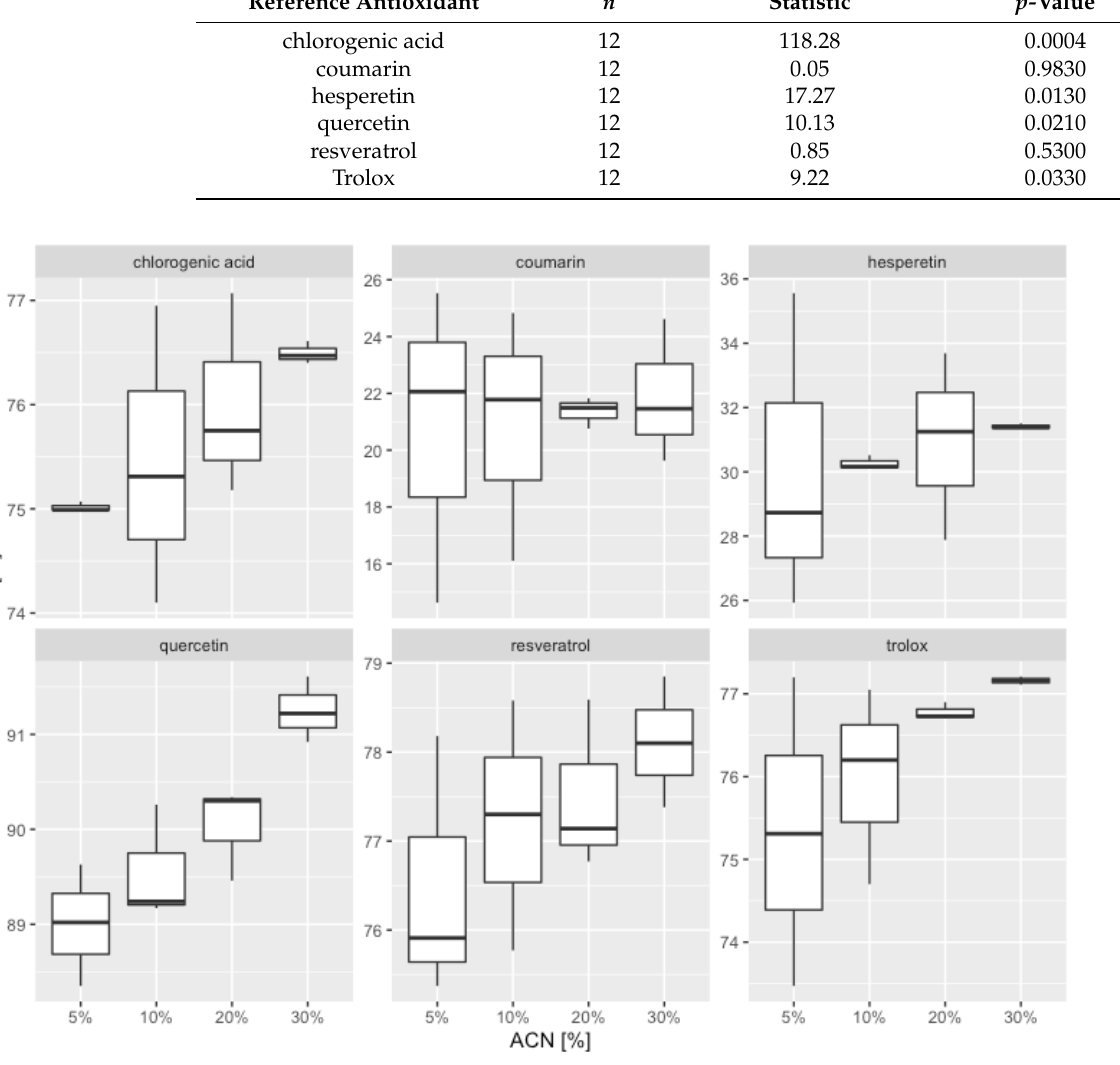
Table 4. Means of peak inhibition values obtained for the selected homogenic groups.